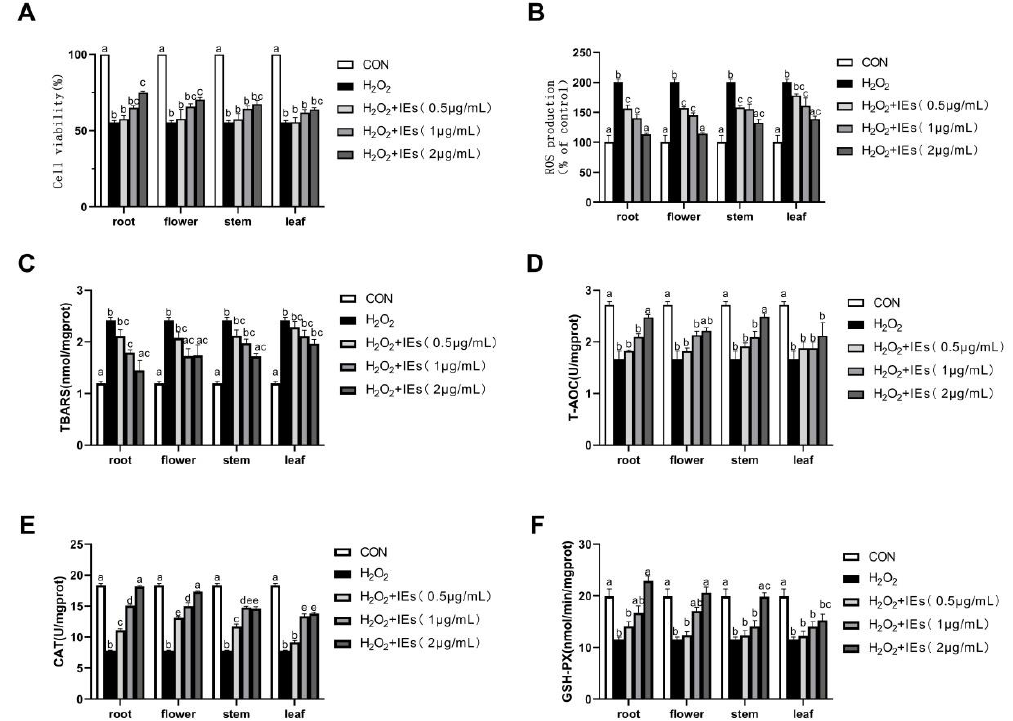
Figure 4. Effects of IEs on ( A ) cell viability, ( B ) ROS production, ( C ) TBARS level, ( D ) T-AOC level, ( E ) CAT, and ( F ) GSH-PX activities in H 2 O 2 -induced HepG2 cells. Values were presented as mean ± S.E.M. ( n = 8). Bars within a figure without a common superscript differ significantly at p < 0.05.